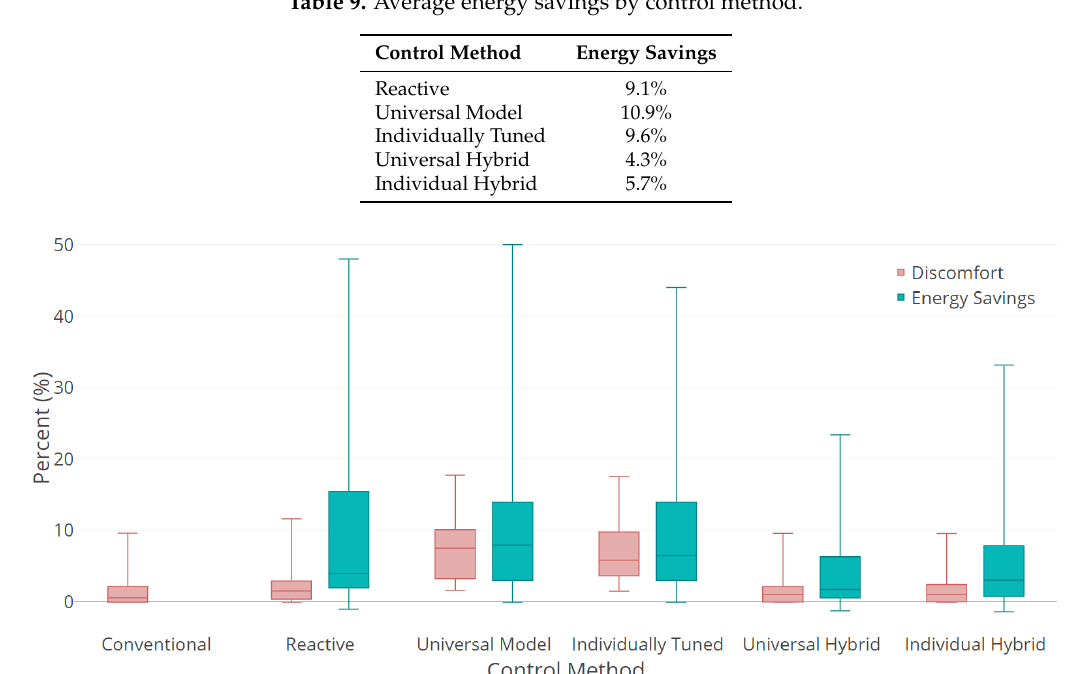
Figure 9. Energy savings and discomfort percent for simulation period by control method [%].